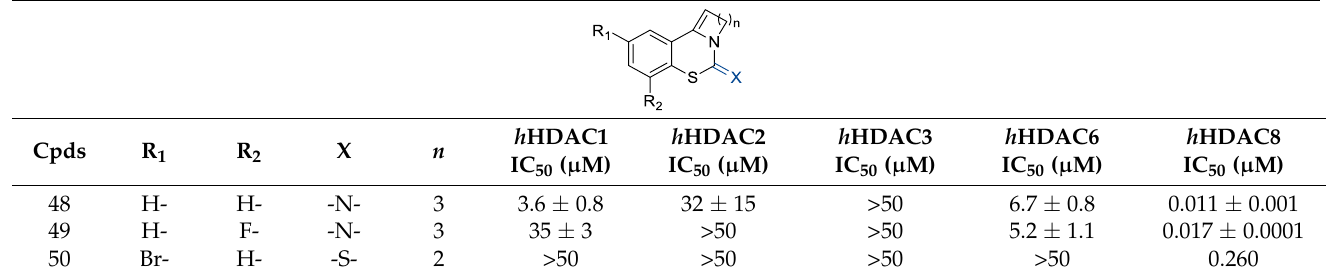
Table 9. General structure and IC 50 values of 48 , 49 , and 50 [156,157].